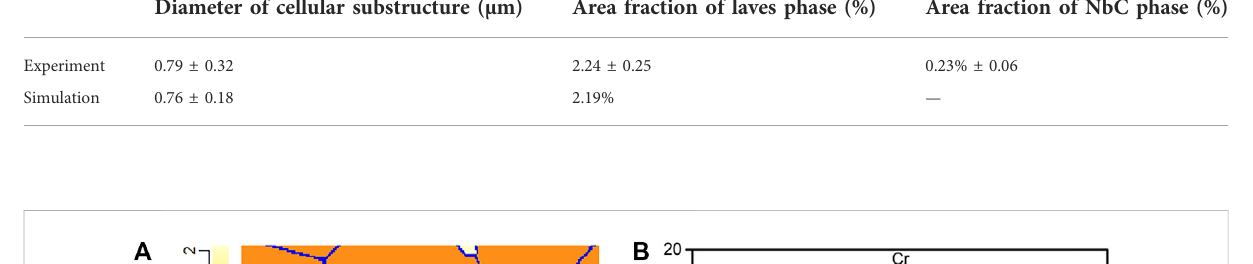
TABLE 4 Experiment and simulation of microstructural characteristics.